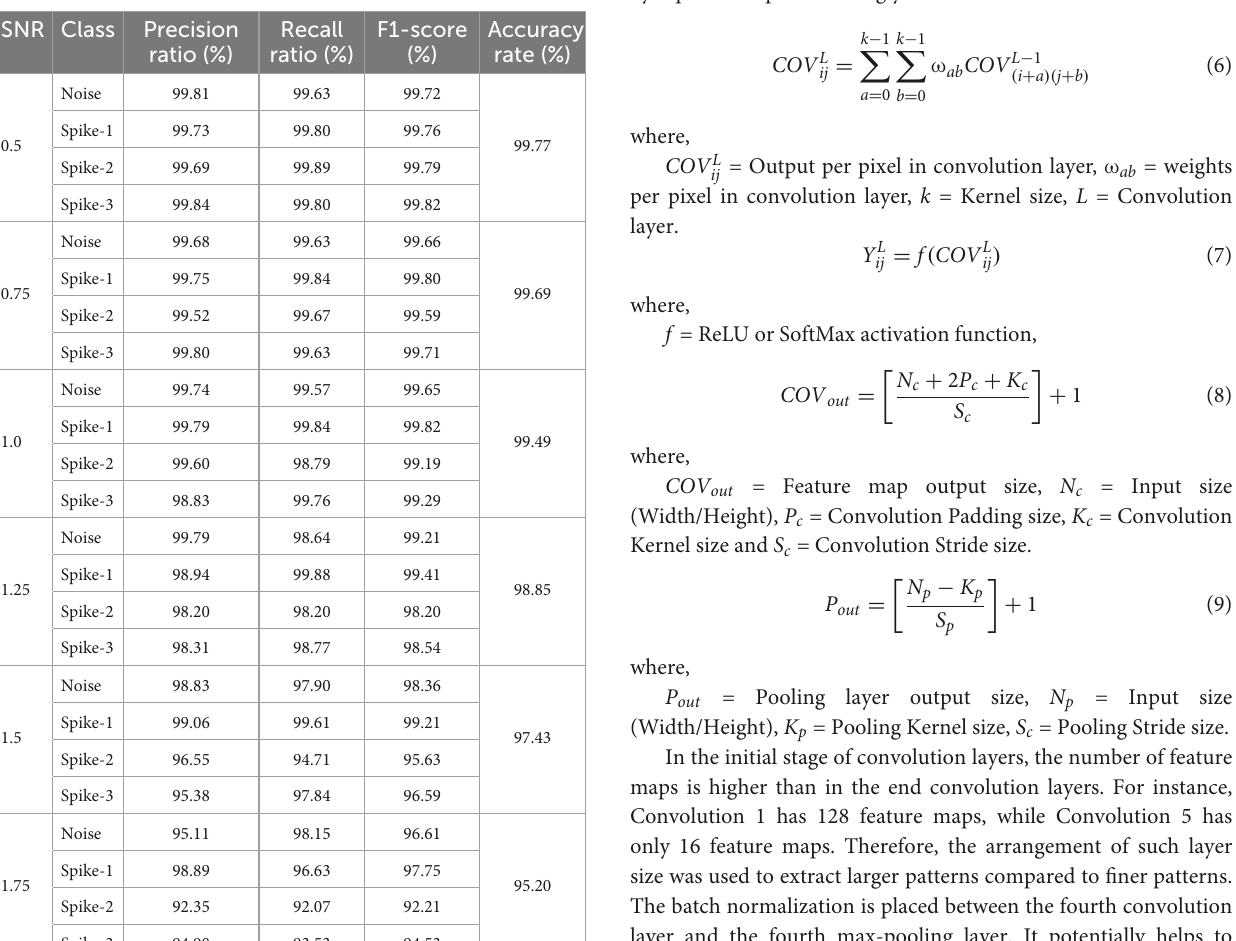
TABLE 5 Performance of proposed approach with 2D CNN for different SNR signals – Precision ratio, recall ratio, F1-score and accuracy rate. SNR Class Precision Recall F1-score Accuracy ratio (%) ratio (%) (%) rate (%)